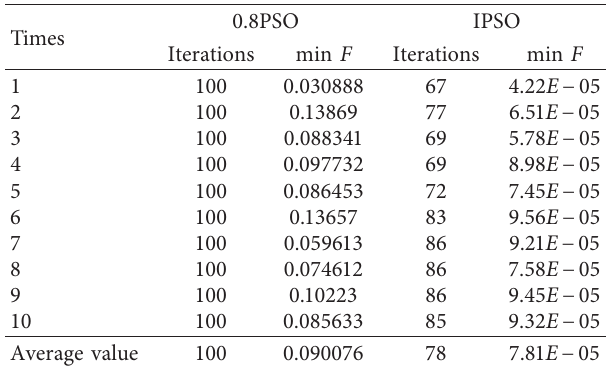
Table 2: Iterations and objective function values of 0.8PSO and IPSO,